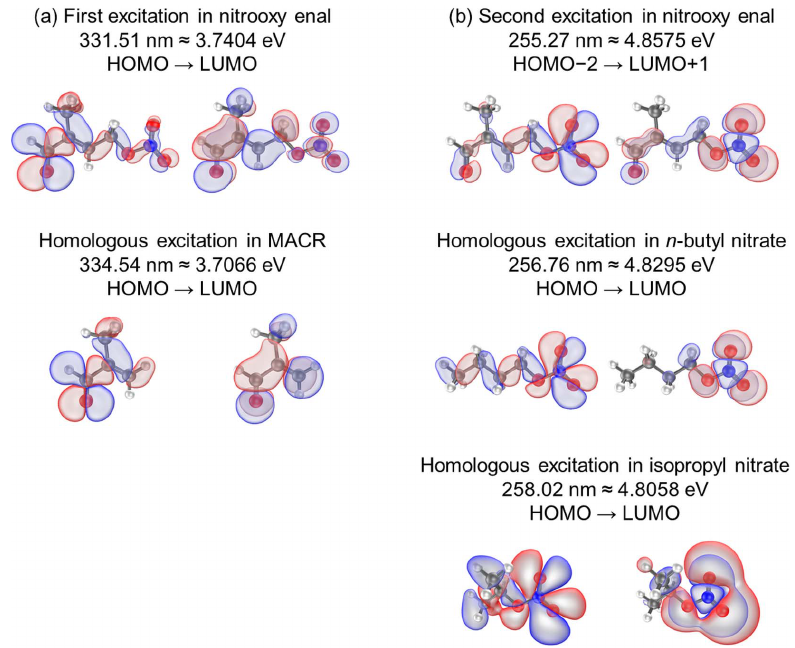
Figure 5. Molecular orbital analysis of the first (a) and second (b) electronic excitations of the nitrooxy enal, along with analogous excitations of MACR, isopropyl nitrate, and n -butyl nitrate. The blue and red colors represent the opposite phases of molecular